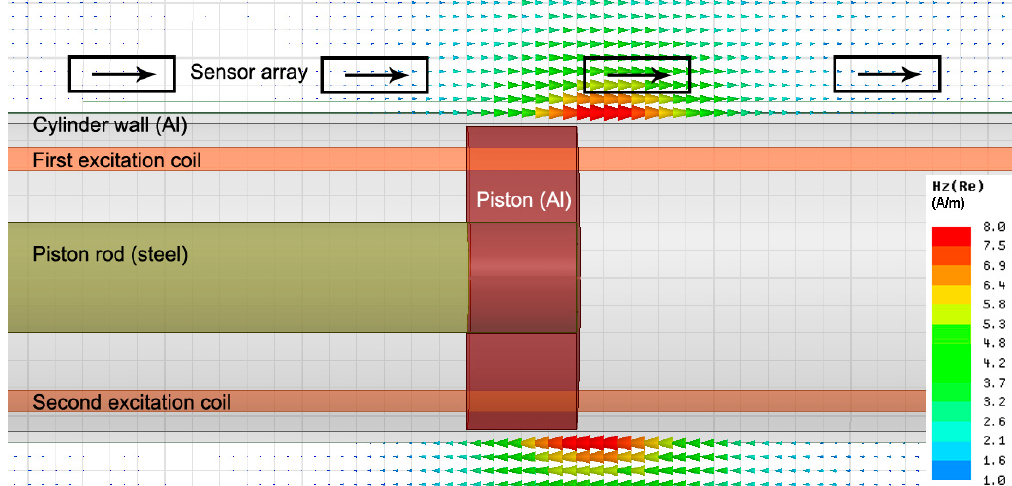
Figure 3. Magnetic field component in axial direction outside the pneumatic cylinder simulated by FEM. Excitation field of 4 Hz in radial direction penetrates the aluminum wall and is substantially deformed near the end of the piston rod made of common magnetizable steel. Sensors are oriented in the axial direction and perpendicularly to the excitation